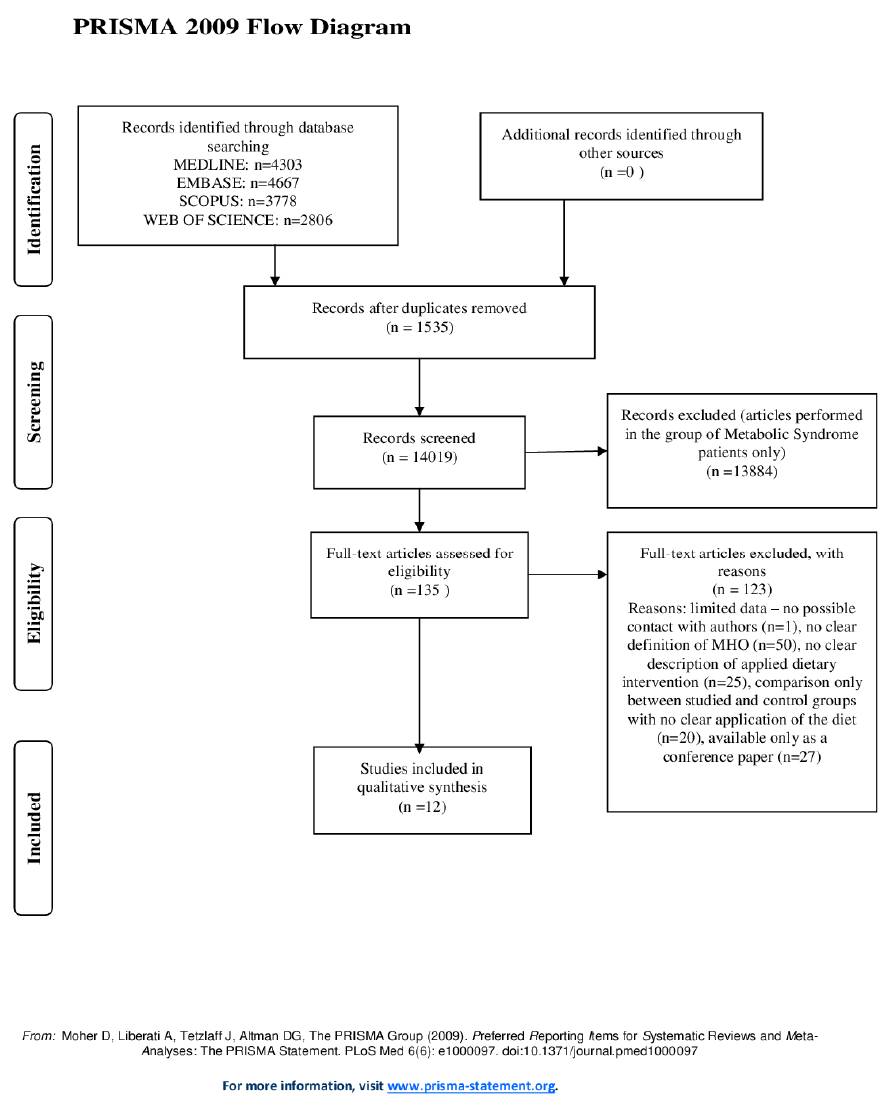
Figure 2. Process of literature search on the association between diet and selected cardio-metabolic parameters in metabolically healthy obese.